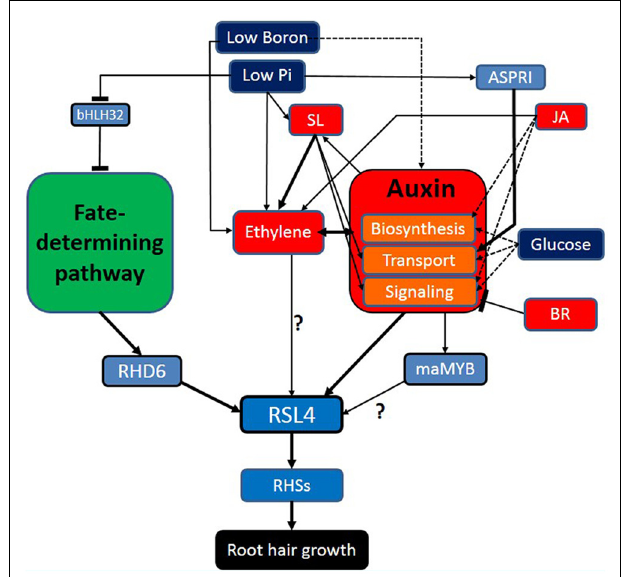
FIGURE 1 |Auxin plays an organizing center for environmental/ hormonal pathways for root hair growth. Navy blue, red, light blue boxes indicate environmental factors, hormones, and genetic factors, respectively. Broken-lined arrows represent the cases where the direct effect on the root hair by the factor has not been shown.The blunt bar end indicates an inhibitory